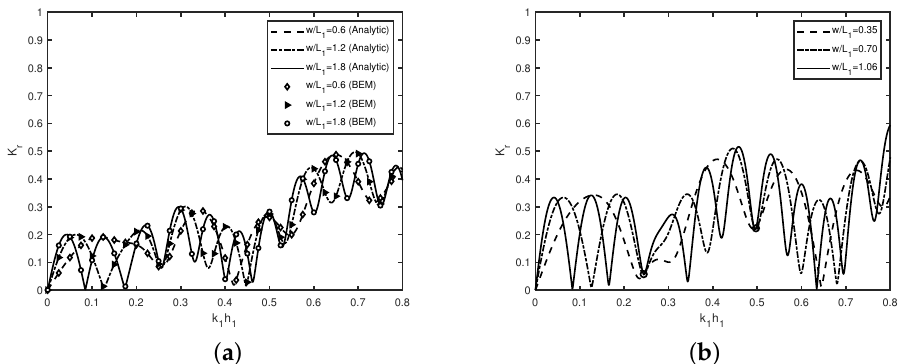
Figure 10. Reflection coefficient K r versus wave number k 1 h 1 in case of single ( a ) trench and ( b ) break- water in the presence of the semi-infinite plate for different values of w / L 1 with L g / L 1 = 0.25 and D / ρ g = 10 5 m 4